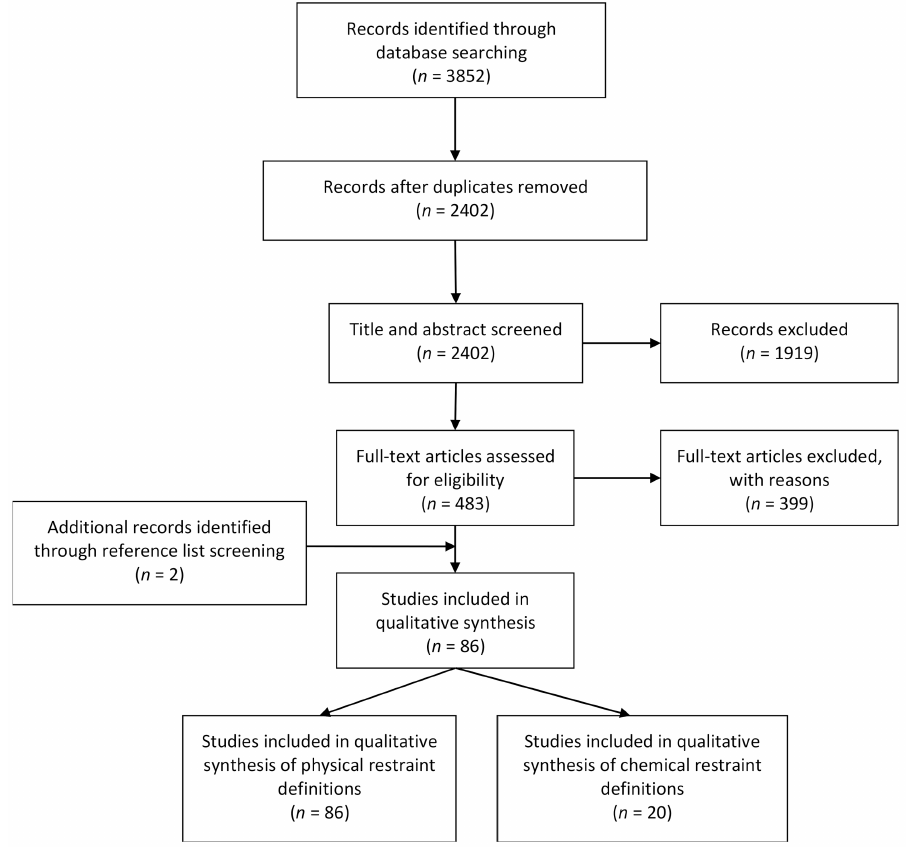
Figure 1. PRISMA flow chart for database search